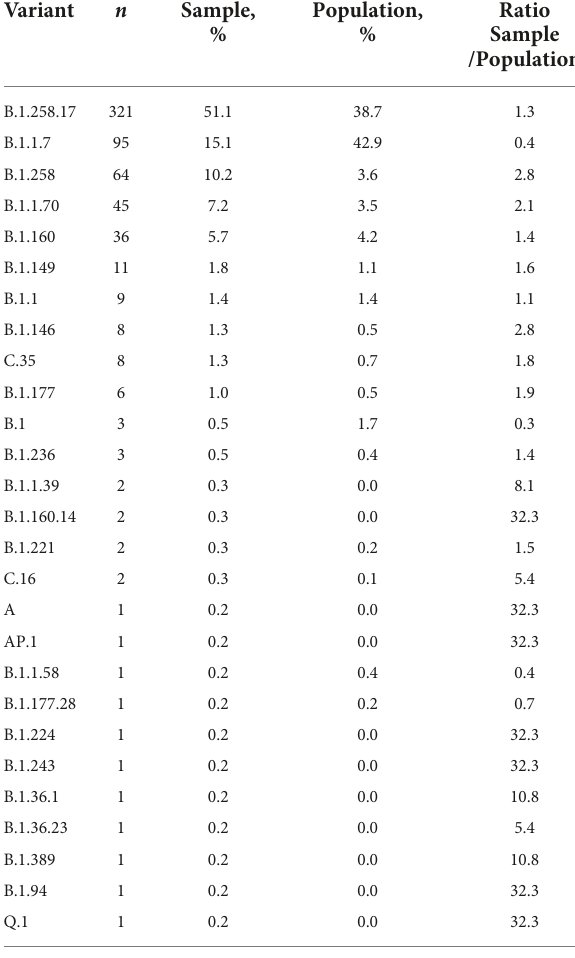
TABLE 2 Genomic variant composition of primary infections in individuals with the Delta variant